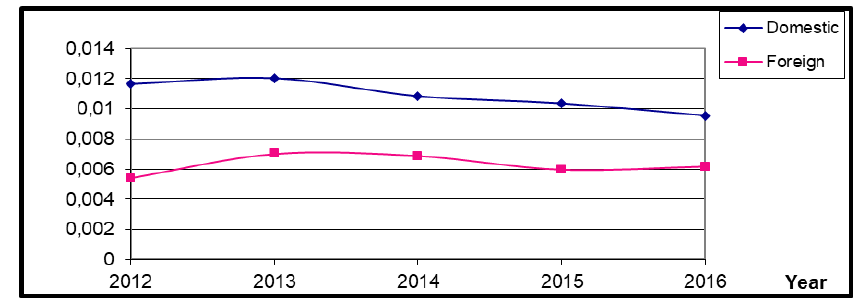
Figure 4: Comparison between domestic banks and foreign banks by using an annual average of return on assets for year